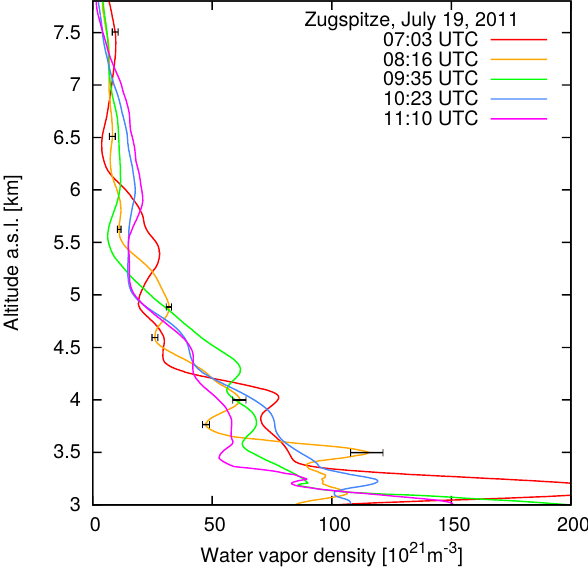
Figure 9. Short-term variability of the water vapor profile under atmospheric instability, high-reaching convection, and only a few hours before the formation of a thunderstorm. The example error bars ( ± 2 σ ) represent statistical uncertainties caused by electronic noise in the